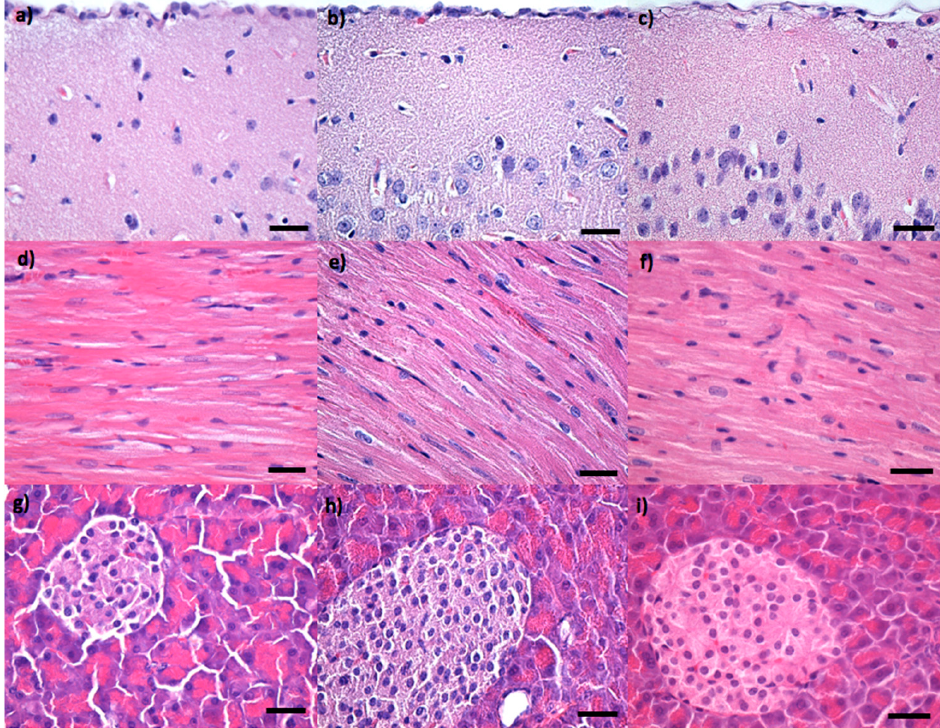
Figure 4. Cross-section through ( a – c ) brain, ( d – f ) myocardium, ( g – i ) pancreas from mice injected with Fe 3 O 4 ( a , d , g ), Fe 3 O 4 @PEG 20 K ( b , e , h ) and Fe 3 O 4 @PEG 35 K NPs ( c , f , i ), respectively, and harvested at two days after intravenous administration; normal morphology; Hematoxylin–Eosin staining; 400× magnification, scale bar 50 μ m.